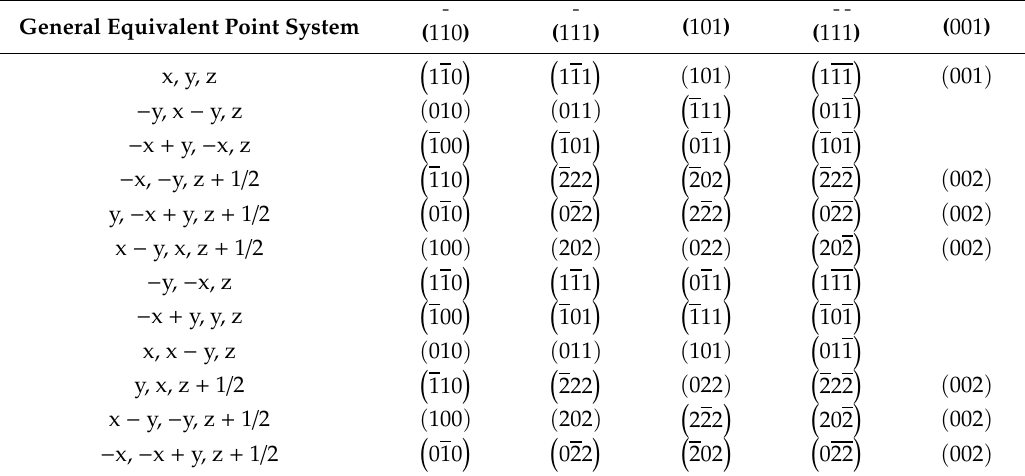
Table 2. Symmetric crystal planes of some crystal planes of h-Fe 7 C